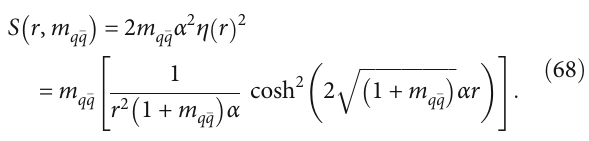
(a) and for in fi nite m q (cid:1) q